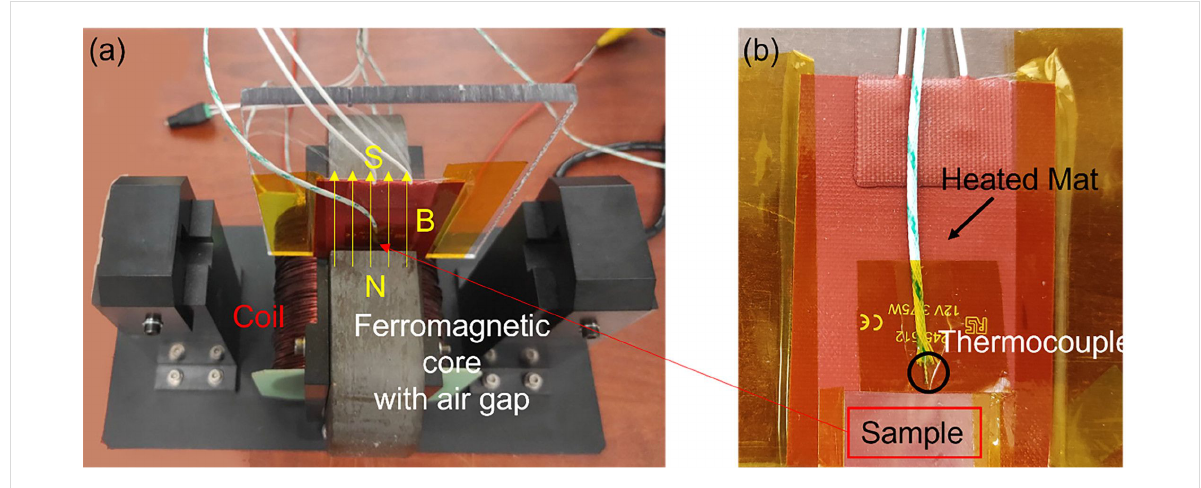
Figure 8: Pictures of the experimental setup. (a) System adopted to apply the DC magnetic field and (b) a detail of the heated mat with the sample.